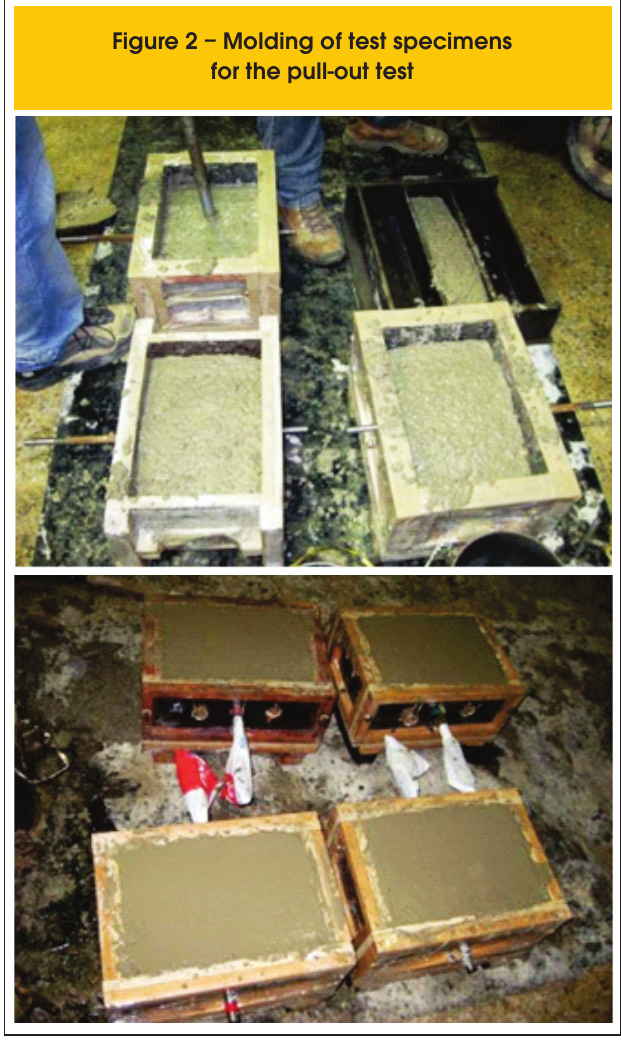
Figure 2 – Molding of test specimens for the pull-out